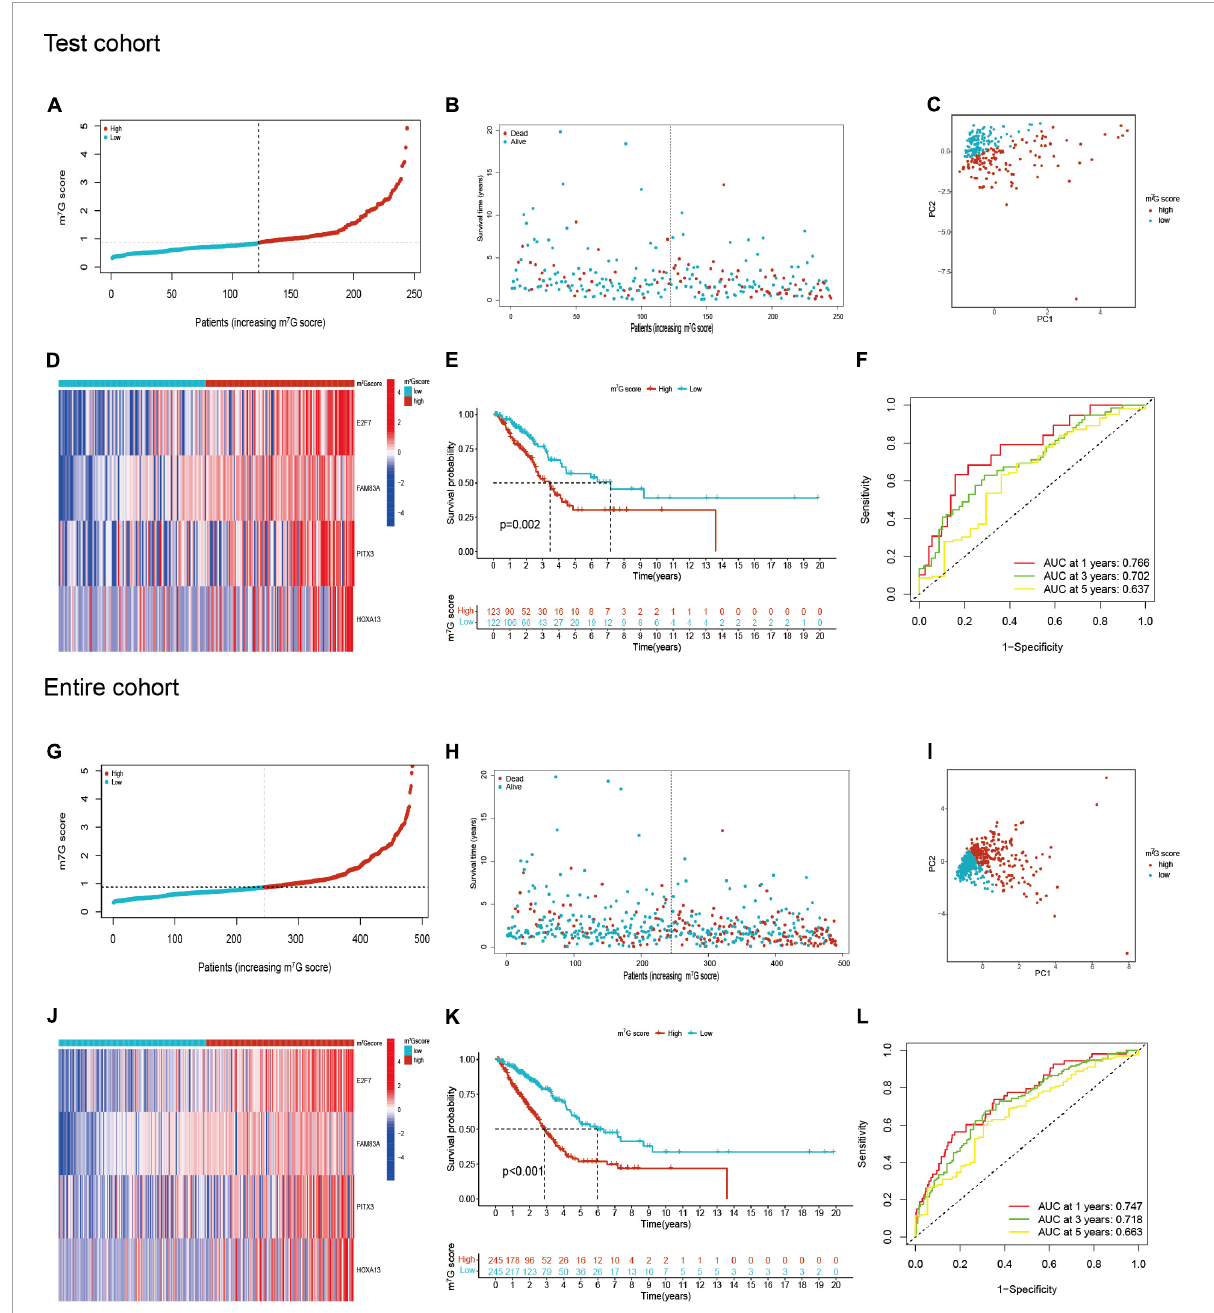
FIGURE6 m 7 G related signature validation in TCGA test cohort and TCGA entire cohort. (A,B) Distribution of m 7 G score and survival state in TCGA test cohort. (C) Distribution of patients in TCGA test cohort. (D) Four genes expression between two groups in TCGA test cohort. (E) Survival analysis between two groups in TCGA test cohort. (F) AUC for predicting 1-, 3-, 5-years survival rates in TCGA test cohort. (G–L) The results of validation in TCGA entire cohort.